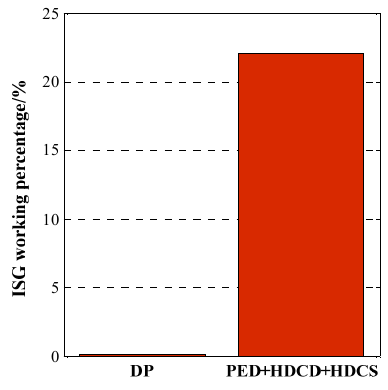
Figure 20. The ISG working percentage under the two types of